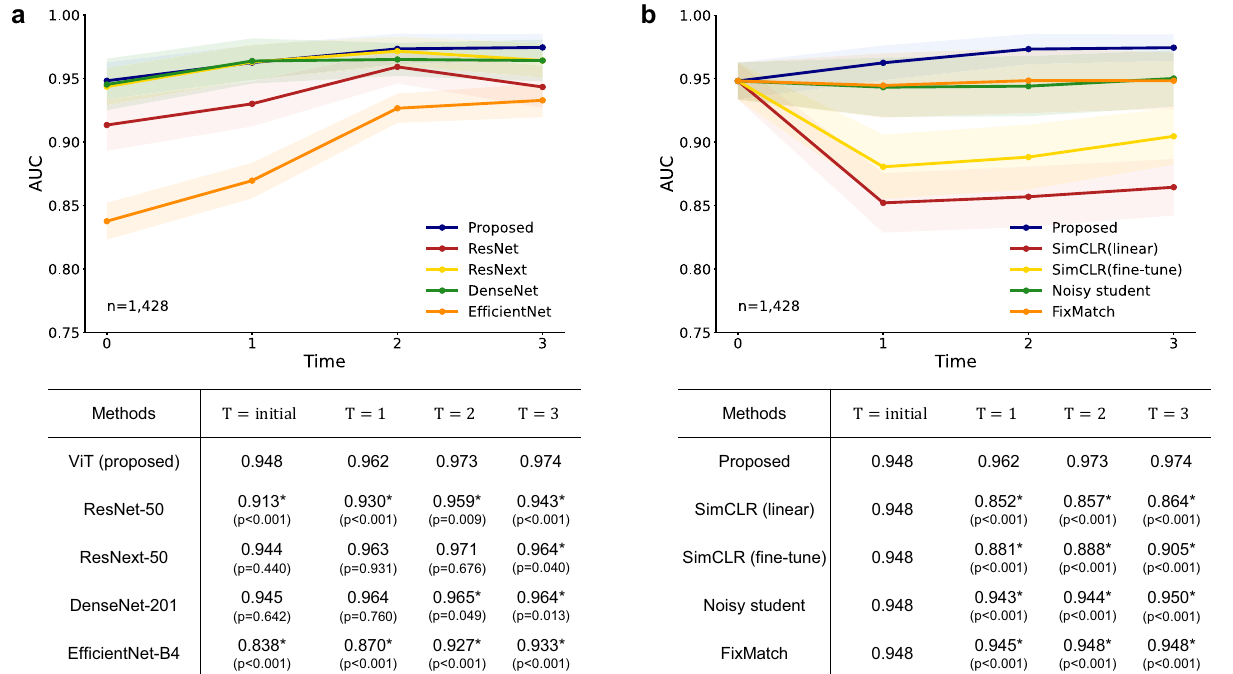
Fig. 4 Tuberculosis diagnosis results for comparison with the other models and methods. a Compared to other convolutional neural networks (CNN)- based models, the Vision Transformer (ViT) model showed a linear increase as well as the best performance among the models. b Unlike the model trained with the proposed framework, none of the existing self-supervised and semi-supervised methods showed a prominent improvement in performance with increasing time T . Data are presented with calculated area under the receiver operating characteristics curves (AUCs) in the study population (center lines)±95% con fi dence intervals calculated with the DeLong's method (shaded areas). The AUCs of the proposed method were compared with the other models or methods at each time point T with the DeLong test to evaluate statistical signi fi cance, except for the T = initial where all methods of comparison start from the same baseline in b . * denotes statistically signi fi cant ( p < 0.050) superiority of the proposed framework. All statistical tests were